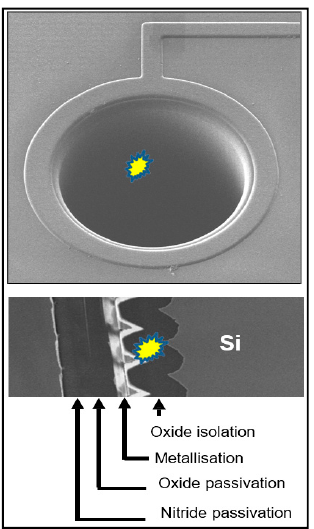
Figure 18. TSV Substrate.